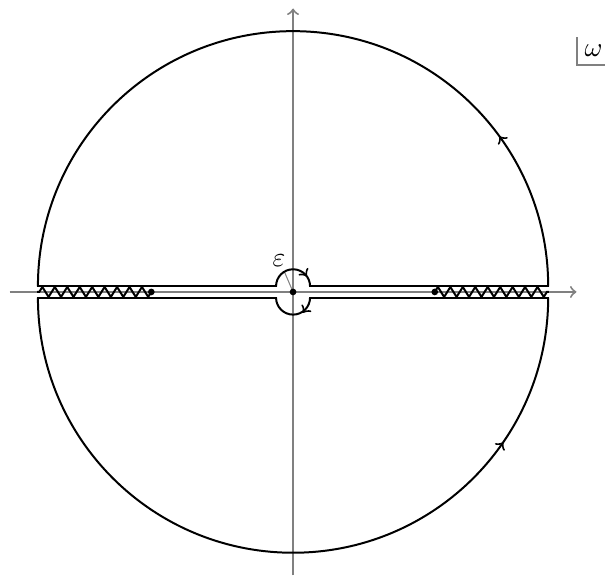
Figure 2 . Different contours that give the same result as in figure 1. This choice is suitable when a cut is running all along the real